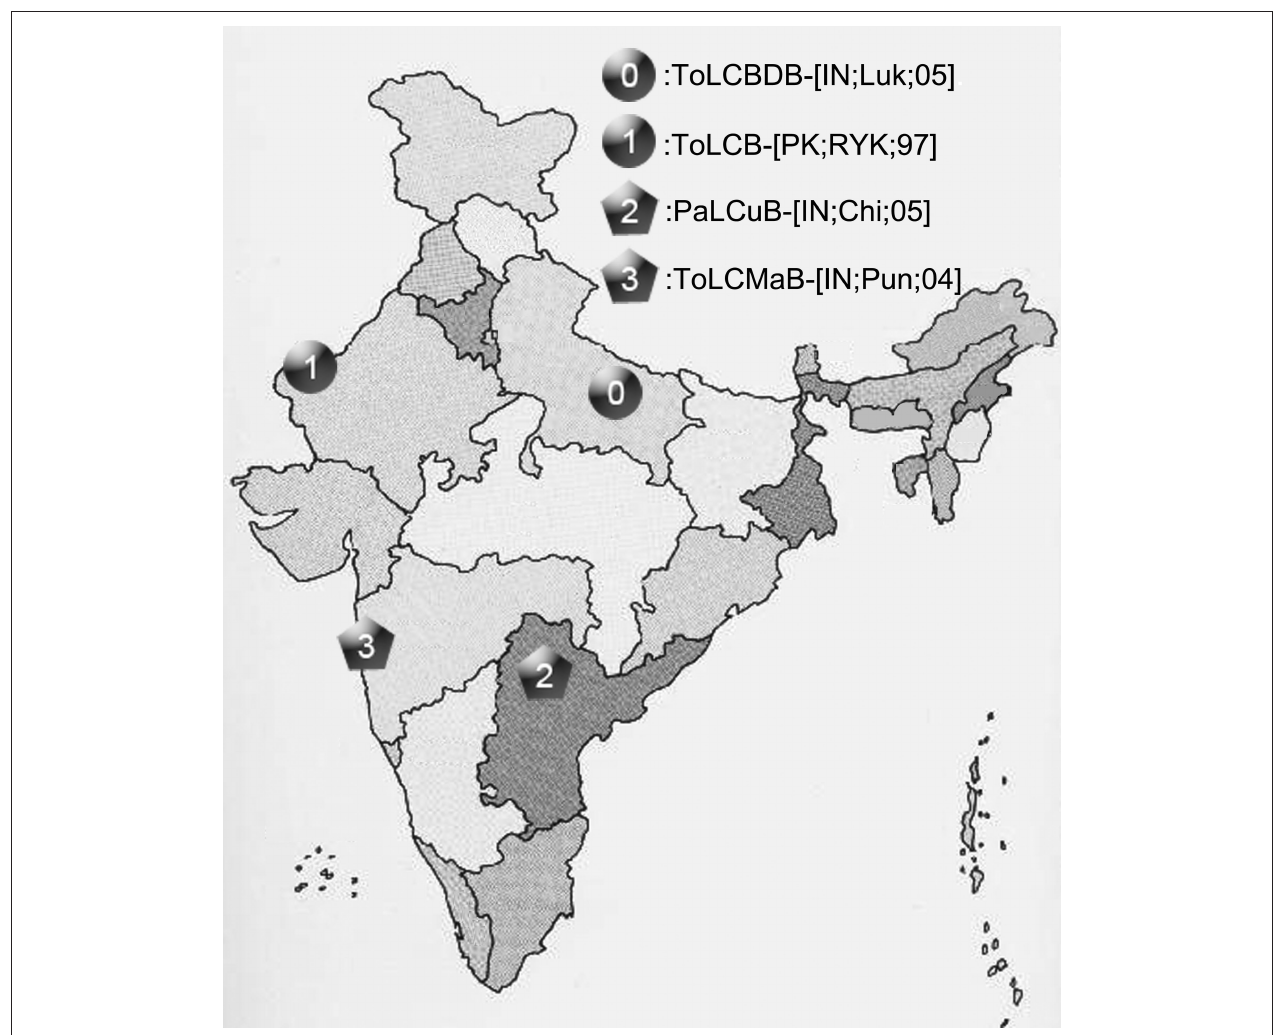
Figure 8 | The geographic distribution of four betasatellites, ToLCBDB-[iN;Luk;05], ToLCB-[PK;rYK;97], PaLCuB-[iN;Chi;05], and ToLCMaB-[iN;Pun;04], associated with ToLCD in the india